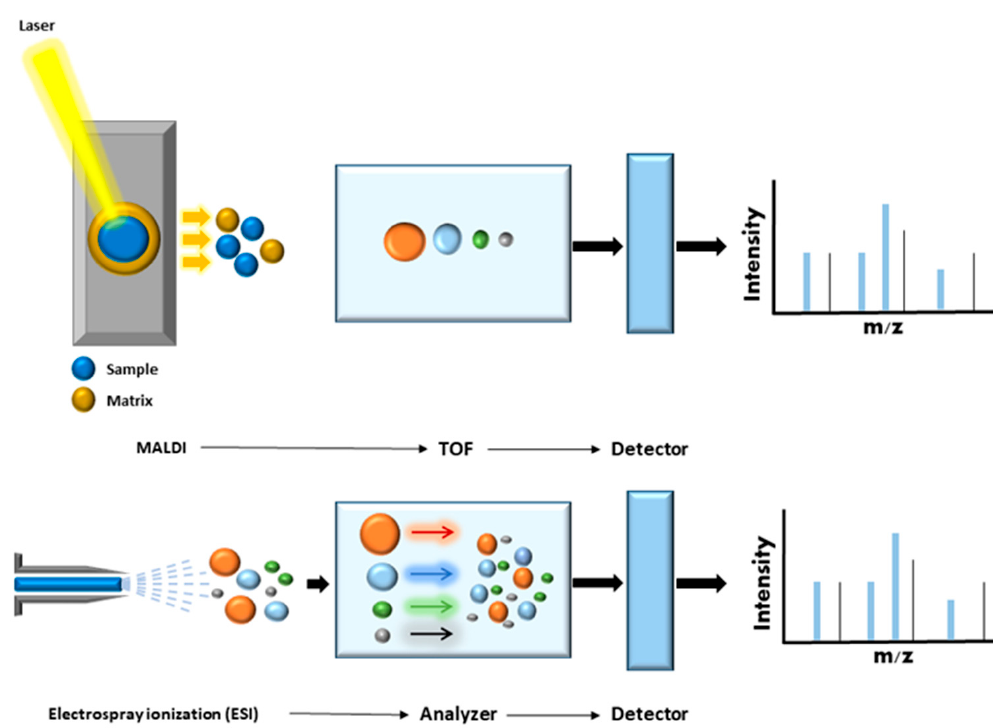
Figure 2. MALDI and ESI Ionization. In MALDI ionization, samples are co-crystallized with an organic matrix on a MALDI plate. A pulsed laser irradiates the co-crystals. This induces rapid heating and desorption of ions into the gas phase. Ions pass through the mass analyzer, such that the smaller peptides reach the detector before the larger peptides (time of flight; TOF). The detector registers the numbers of ions at each individual mass-to-charge (m/z) value, and then the peptide mass fingerprint is generated. In ESI-MS, sample molecules (peptides) are ionized directly in solution. The peptide solution passes through a heated capillary device, and droplets of solution are then sprayed into a vacuum chamber containing a high-strength electric field. The resulting ions pass through a mass analyzer and reach the detector, generating complex spectra with multiply charged ions.